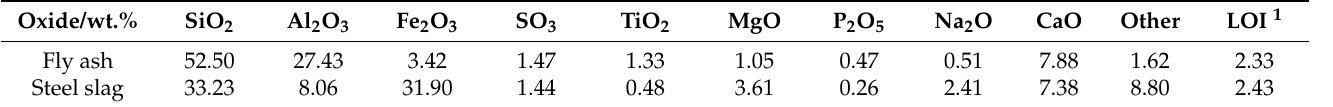
Figure 1. XRD patterns of FA and SS. Table 1. Compositions of fly ash and steel slag by XRF analysis.